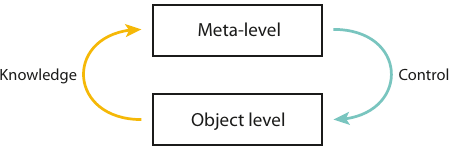
Fig. 1 Model of metacognitive processes. Meta-knowledge is characterised as the upward fl ow from object-level to meta-level. Meta-control is characterised as the downward fl ow from meta-level to object-level. Metacognition is therefore conceptualised as the bottom-up monitoring and top-down control of object-level processes. Adapted from Nelson and Narens ’ cognitive psychology model of metacognition 23